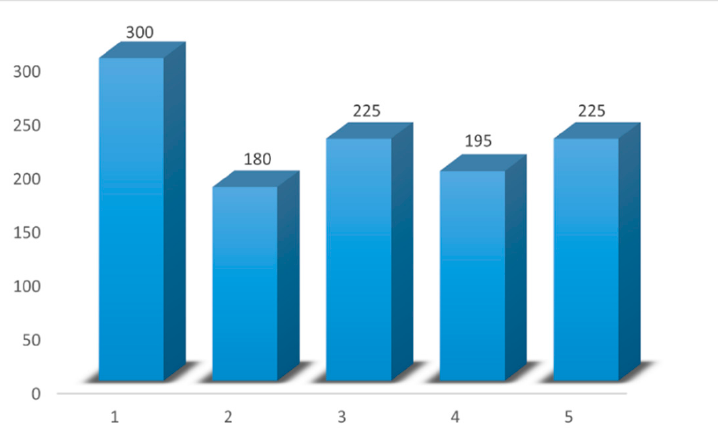
Figure 8. Sizes of samples necessary to reach the rejection of 𝐻 (cid:2868) for the real-life example.